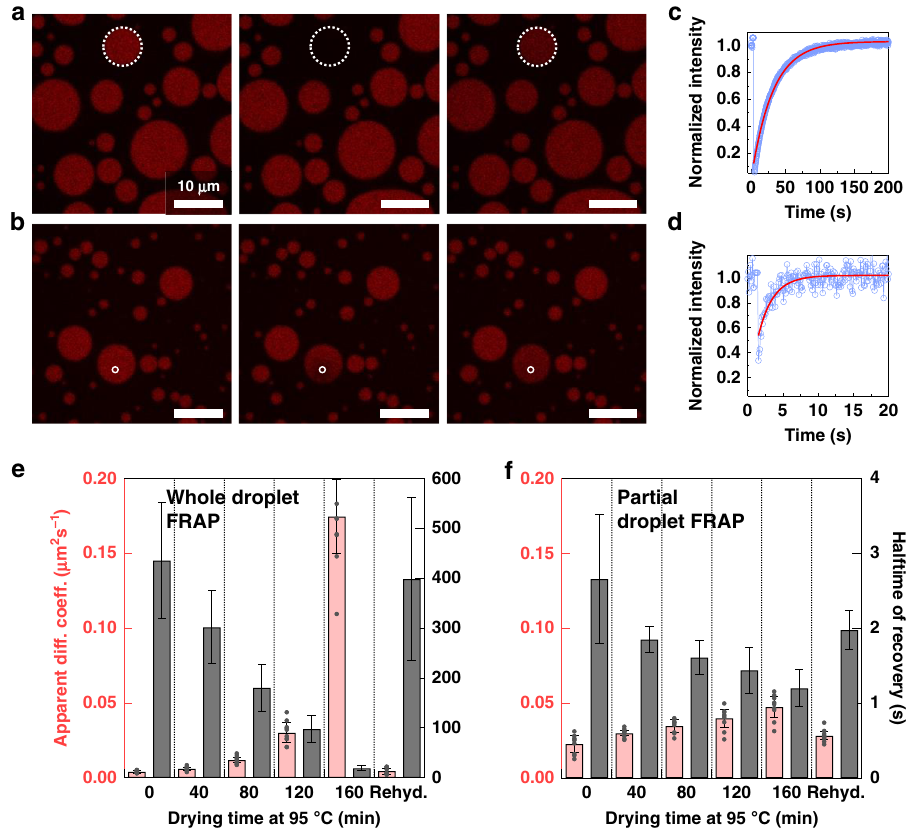
Fig. 3 Dynamics of U15 in the complex coacervate during drying. a Fluorescence recovery after photobleaching, FRAP, over a whole 1:1 PDADMA:PAA coacervate droplet in solutions dried at 95 °C for 160 min and allowed to return to room temperature before partitioning Alexa 647-U15 within. b FRAP over part of the same coacervate in solutions dried at the same temperature for 80 min and allowed to return to room temperature before adding U15. c Recovery of the fl uorescence after whole-droplet photobleaching of U15 partitioned within a coacervate in mixtures allowed to dry for 160 min. d Recovery of the fl uorescence after partial-droplet photobleaching of U15 partitioned within a coacervate in mixtures allowed to dry for 80 min. Circle markers represent corrected fl uorescence intensity in c, d . Lines are fi tting results according to equations mentioned in the Methods section. e Apparent diffusion coef fi cients and recovery halftimes of U15 as it recovers after bleaching of whole coacervate droplets at each time point of the drying experiment. f Apparent diffusion coef fi cient and recovery halftimes of U15 as it recovers after bleaching of partial droplets at each time point. The bars are averages of fi ve trials with at least two droplets each in e . In f , the bars are averages of three trials with at least three droplets analyzed in each. All individual data points are shown in Supplementary Tables 2 and 3, and as gray markers for the apparent diffusion coef fi cients in e and f . The error bars represent the standard deviations among all